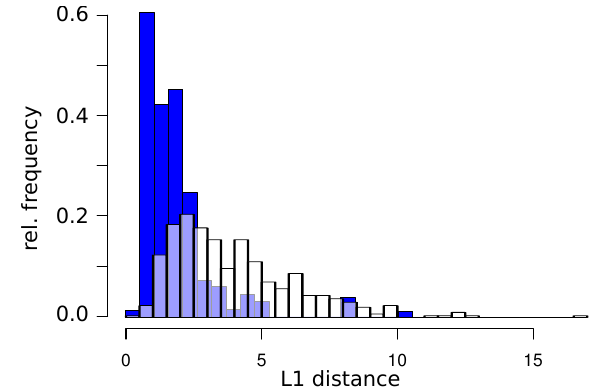
Figure 6. Histogram of prior (white) and posterior (blue) distribu- tion of L1 distances to the true ADMs, for the experiment with only time-uncertain proxies. The histograms bin distances over all eight time-uncertain